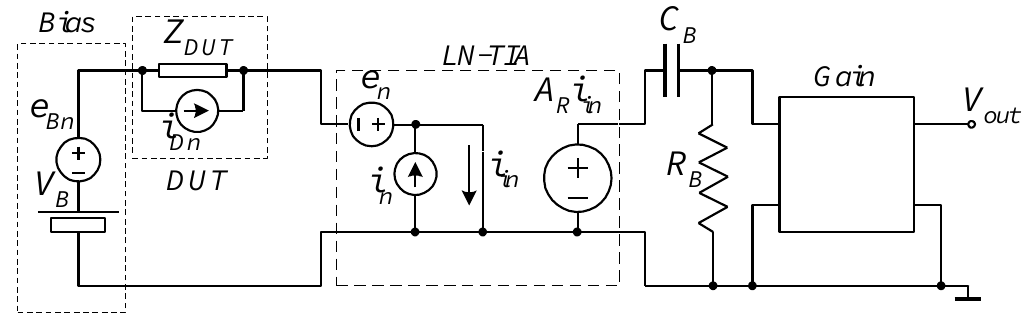
Figure 9. Block diagram of basic set up for current noise measurements.